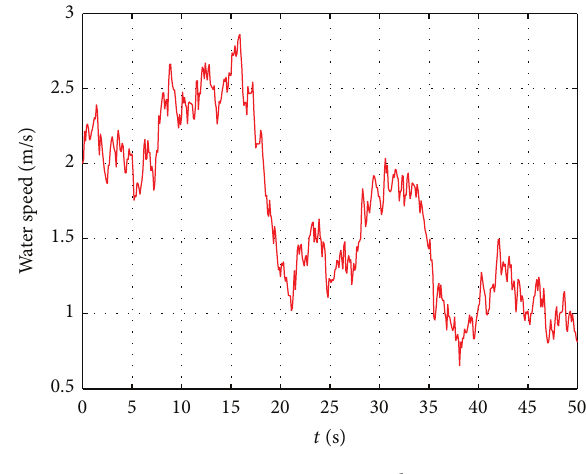
Figure 10: Water speed.